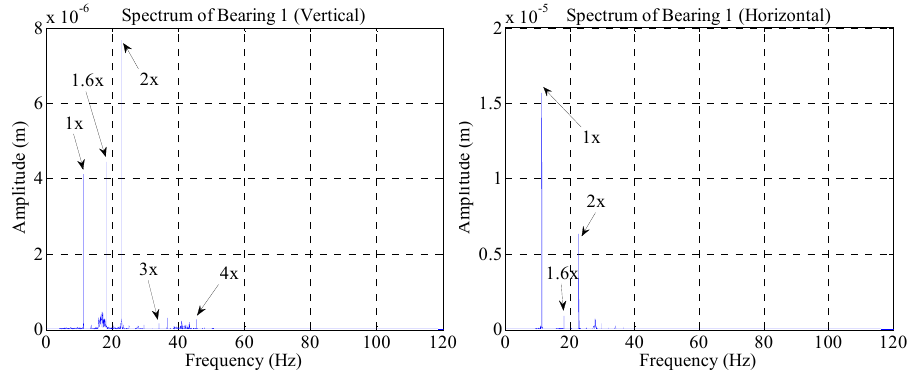
Figure 19. The spectrum of horizontal and vertical direction of Bearing 1.